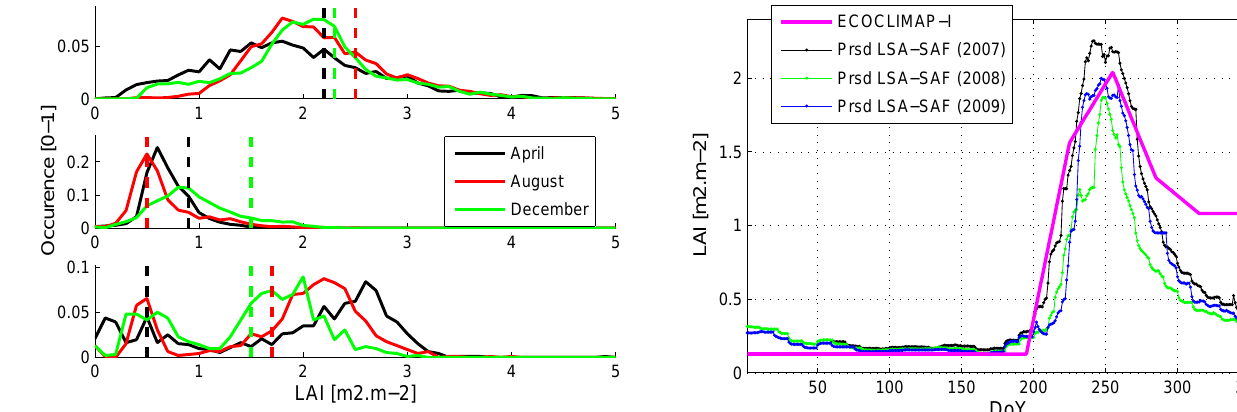
Fig. 4. Time series comparison of processed LSA-SAF LAI (Prsd LSA-SAF) for 2007, 2008 and 2009, and re-scaled and linearly interpolated ECOCLIMAP-I LAI for a pixel in Western Africa (15.29 ◦ N, 1.49 ◦